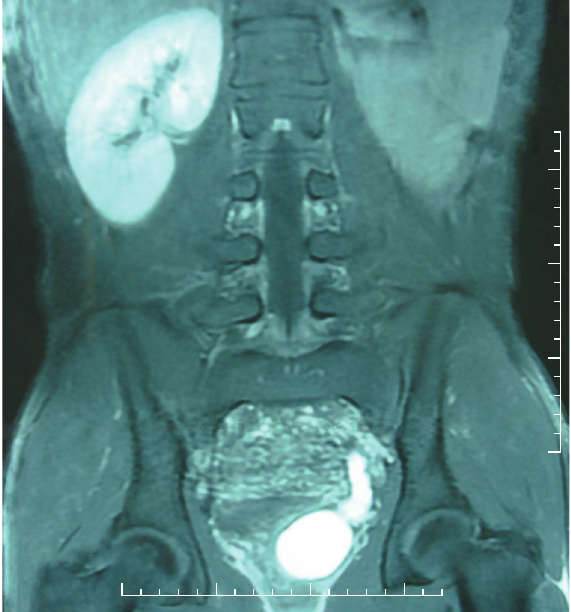
Figure 2: MRI showing a tube-like structure meandering along the rear wall of the bladder corresponding to the distal ureter, a cyst in the seminal vesicle area and renal